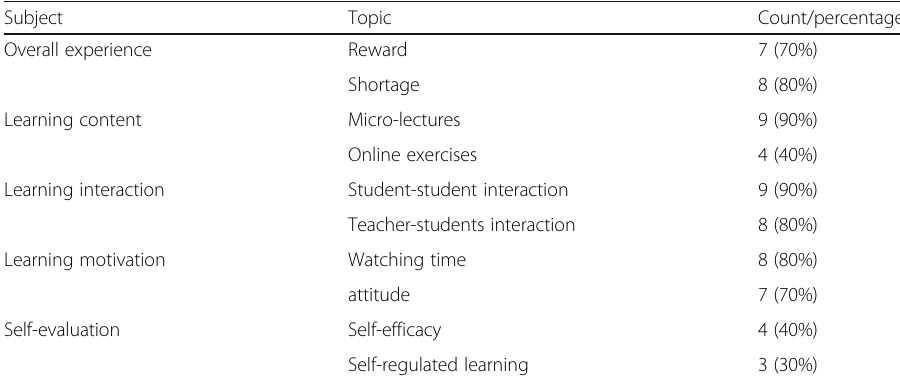
Online exercises